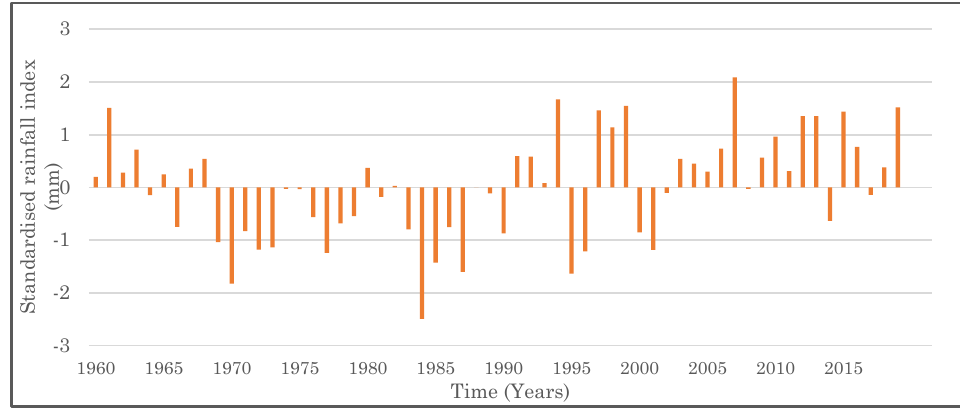
Figure 3. Variability of rainfall patterns from 1960 to 2019. Table 1. Trends of TWSC, SWC, and GWSC.